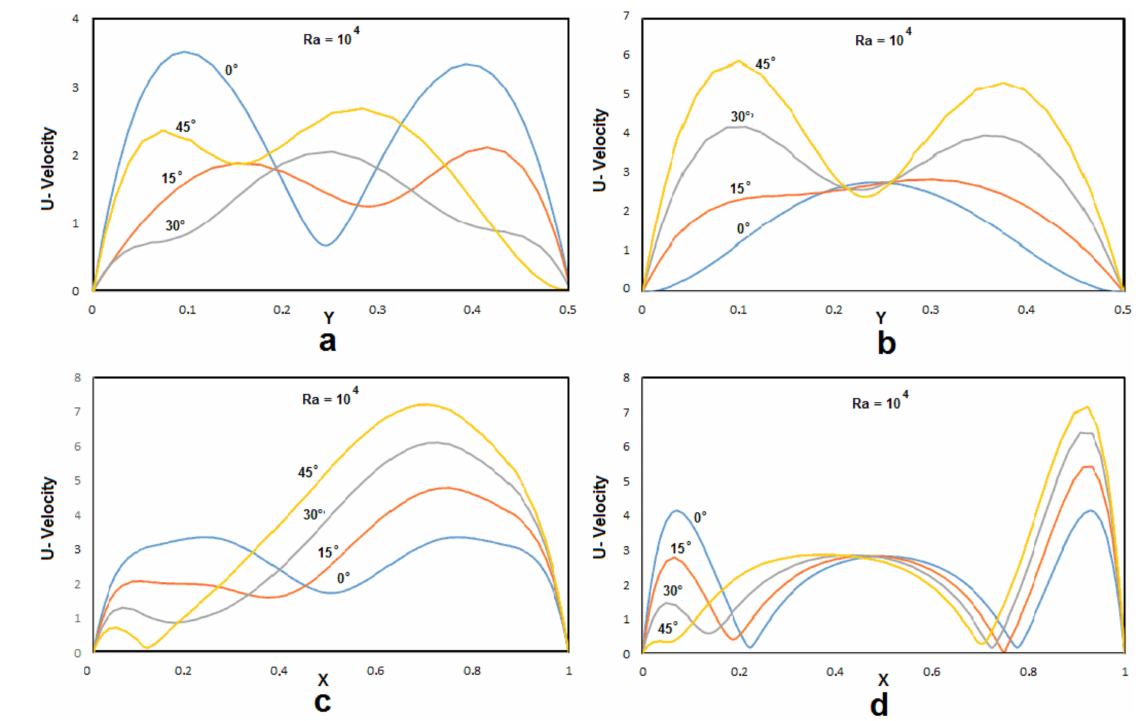
Figure 6. Nanofluid velocity evolutions at the levels: X = 0.25 ( a ) X = 0.5 ( b ) Y = 0.25 ( c ) Y = 0.5 ( d ) for a Rayleigh number Ra = 10 4 .